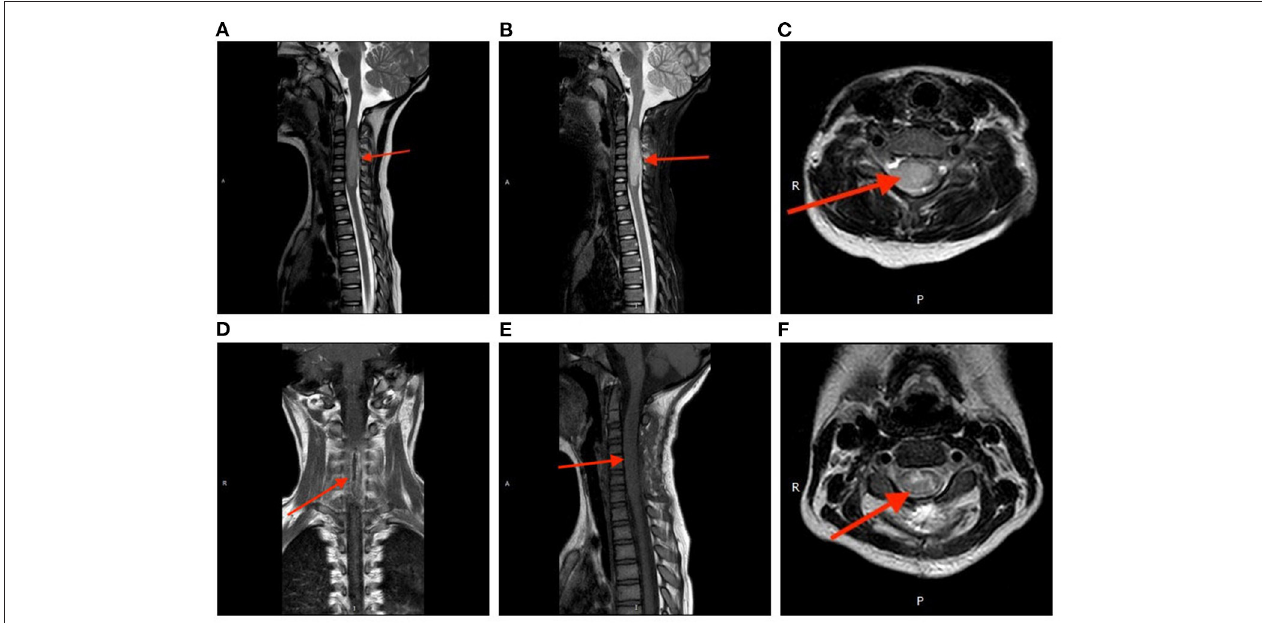
FIGURE 1 | Perioperative magnetic resonance imaging. The tumor showed isointensity on T1-weighted imaging (A) and slightly hyperintensity on T2-weighted imaging (B) . After administration of contrast medium, the lesion was heterogeneously enhanced (C) . Postoperative spinal MRI confirmed a subtotal resection of the tumor (D) coronal, (E) sagittal, (F) axial.